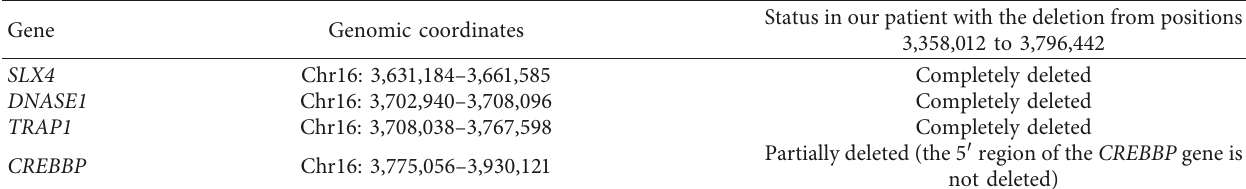
Figure 1: (a) Broad and radially angulated thumbs. (b) Broad halluces. (c) Bulbous nasal tip, a columella hanging below the alae nasi, and a pouting lower lip. The two paramedian rounded areas in the lower lip are vermilion elevations with no fistulae. (d) Bifid tip of the tongue. Table 1: The genomic coordinates of the deleted genes of interest in our